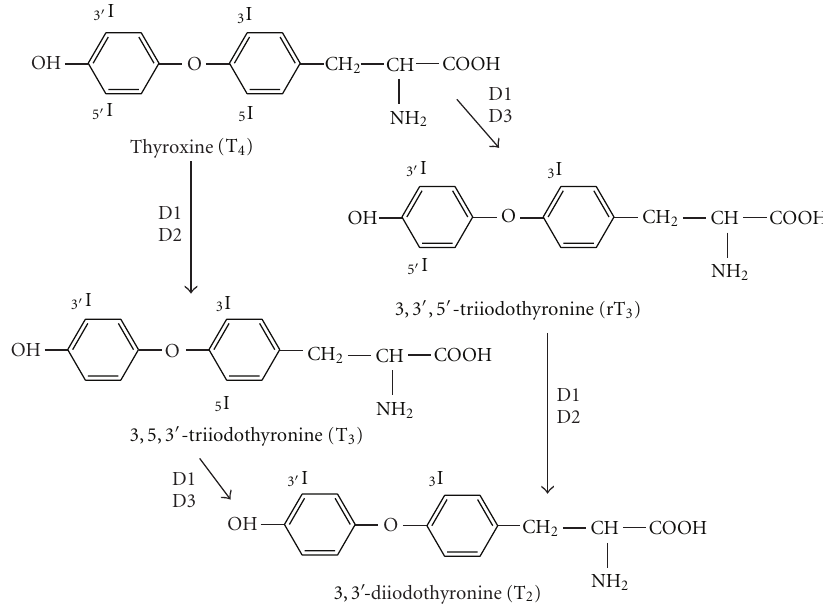
Figure 2: Thyroid hormone metabolism. D1: Type 1 deiodinase; D2: Type 2 deiodinase; D3: Type 3 deiodinase.